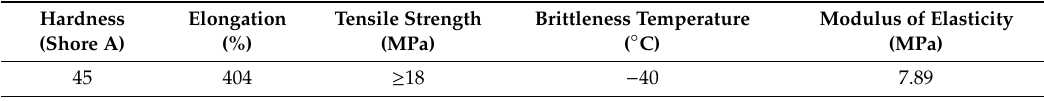
Table 4. Material properties of NR45 ◦ natural